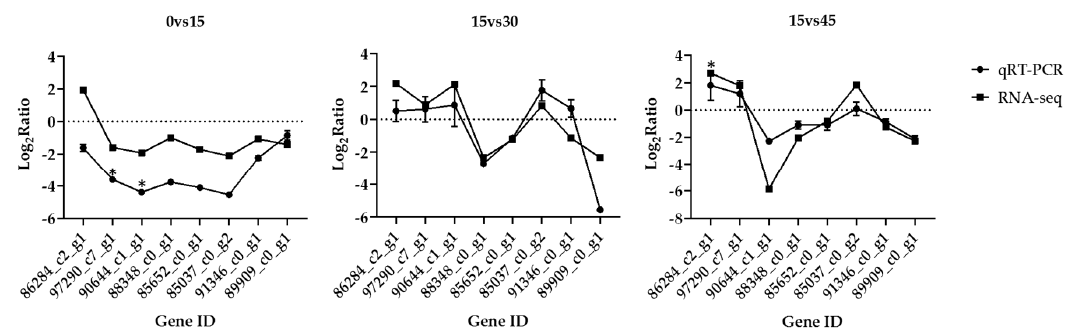
Figure 4. Relative change of the transcriptomes data and qRT-PCR data of 8 DEGs. Log 2 fold changes are expressed as the ratio of gene expression after normalization to β -actin. The data are means ± SD from three independent replicates, and “*” indicates statistical significance between experimental group and control group ( p < 0.05) .